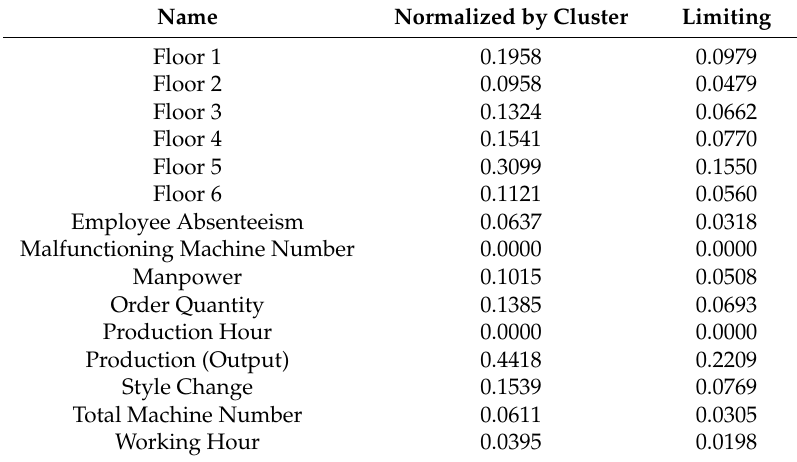
Table 2. Priorities of the factors using ANP.